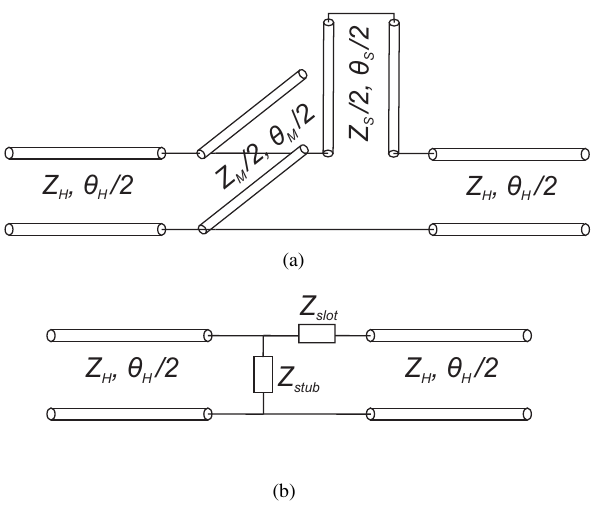
Figure 2: Equivalent circuit of the proposed unit-cell of Fig. 1.(b) is a simplified version of (a). Z slot and Z stub are de- fined in (1a) and (1b), and Z S , Z M , θ S and θ M , in the text below